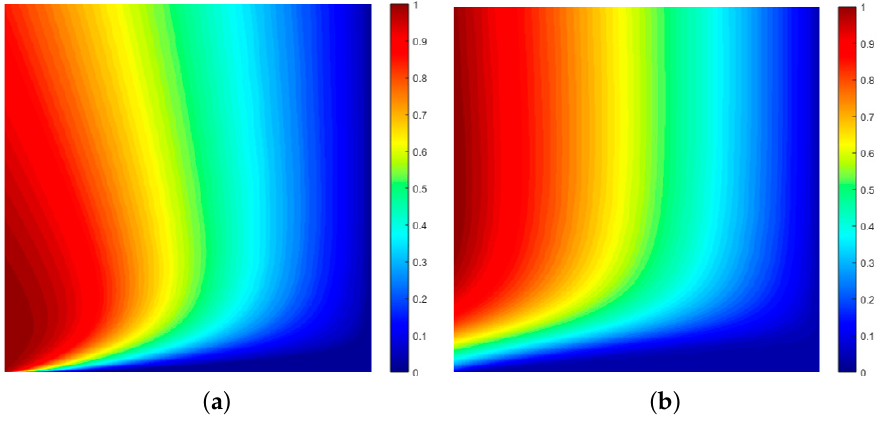
Figure 4. Comparison of the space-time maps for the (space) fractional diffusion of particles in- teracting with a random medium for γ = 1.9 ( a ) and γ = 1.1 ( b ). In both cases, the horizontal axis and the vertical axis, are of space x and time t , respectively, where ( 0,0 ) is the lower left-hand corner of the map. ( a ) Space-time map of the function u γ ( x , t ) given by Equation (65) for γ = 1.9; x ∈ [ 0,1 ] , t ∈ [ 0 + ,1 ] ; ( b ) space-time map of the function u γ ( x , t ) given by Equation (65) for γ = 1.1; x ∈ [ 0,1 ] , t ∈ [ 0 + ,1 ]